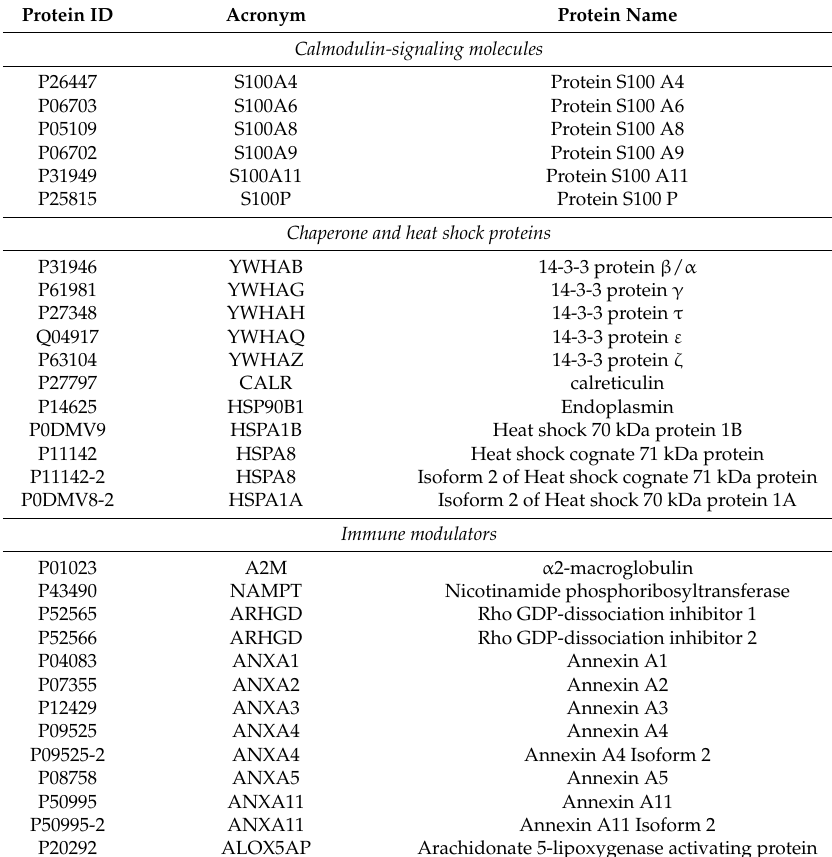
Table 3. Signaling and immune modulators, chaperones, and heat shock proteins in wound fluids. GDP: Guanosine-5 (cid:48) -triphosphate.